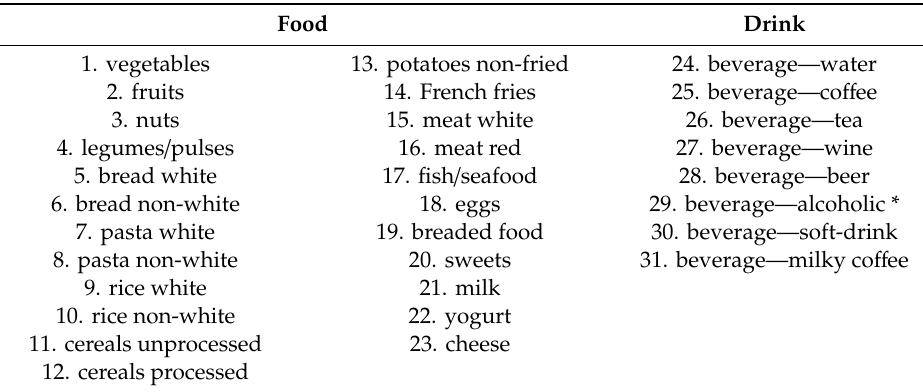
Figure 3. Example daily sub-set. Table 2. Food and beverage